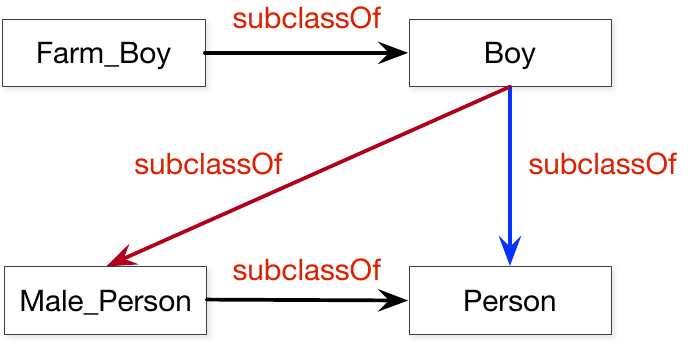
Figure 1. An example of the missing one subclassOf axiom for schematic knowledge